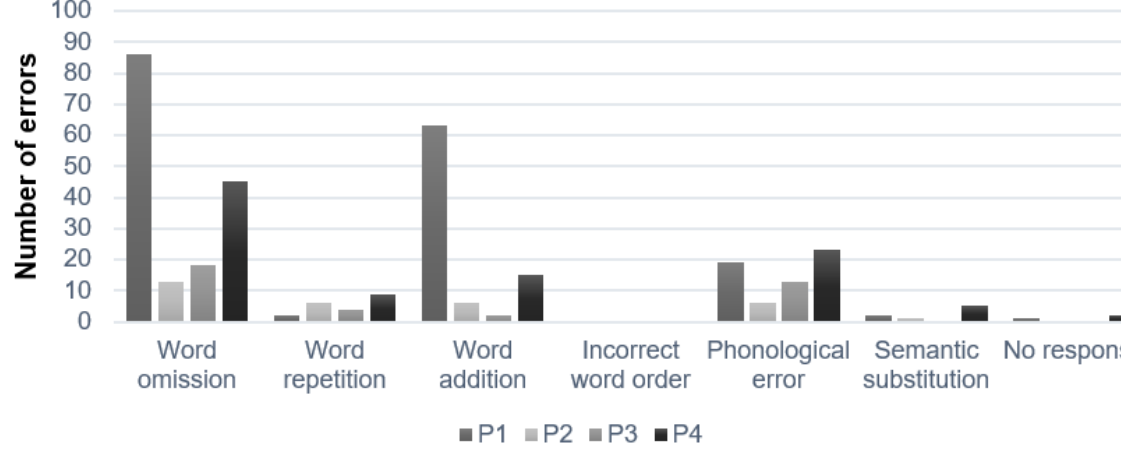
Figure 2. Error patterns on sentence